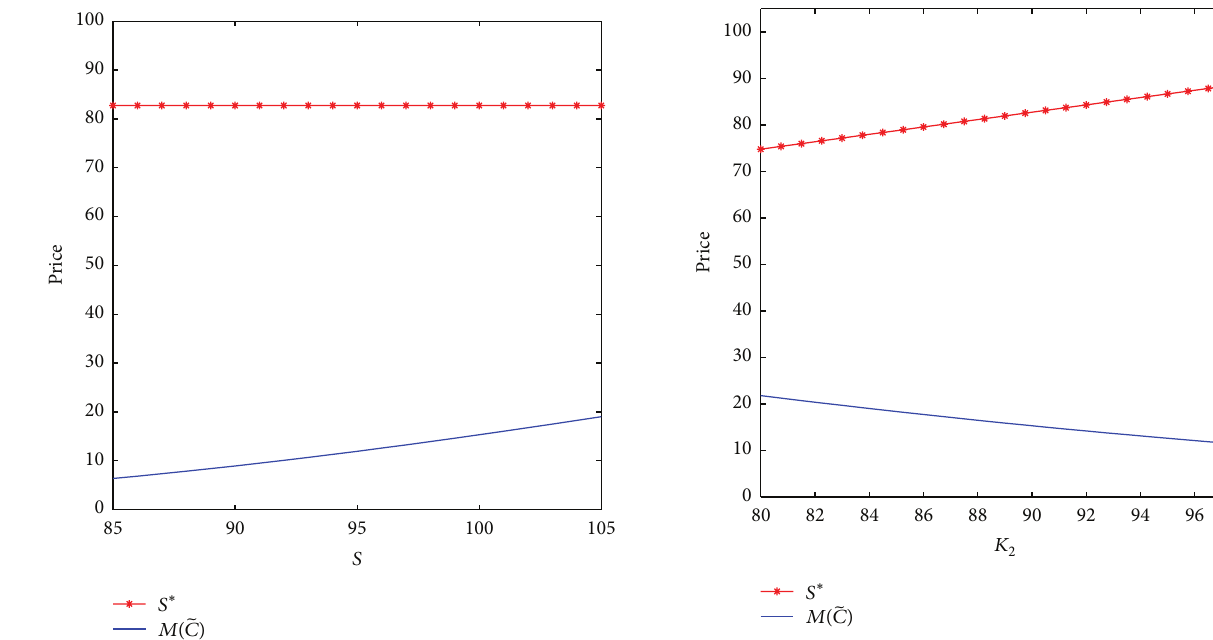
𝑀(̃𝐶) with respect to 𝑆 .